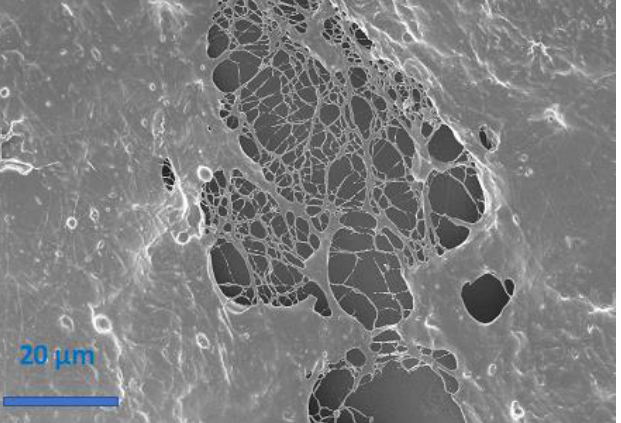
Figure 6. FESEM image of MC material submitted to bending in traction mode. The rupture of the material was evidenced in this image.